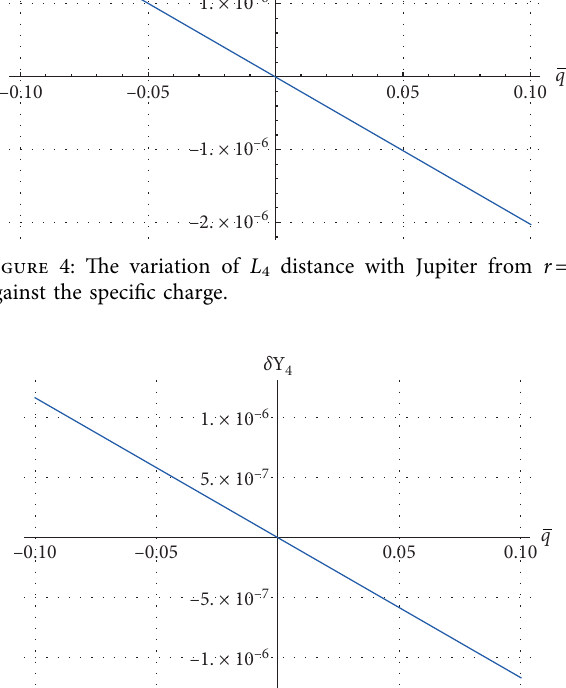
� √ y � 3 /2 against the